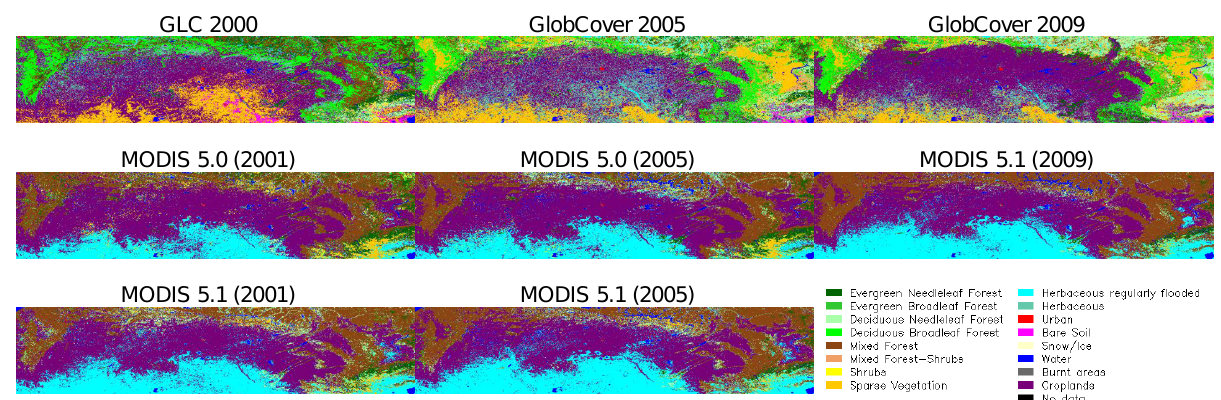
Figure 3. Comparison of five land cover products in southwest Siberia: GLC2000, GlobCover 2005 and 2009, MODIS 5.0 and 5.1 for 2001, 2005 and 2009, aggregated at 1km scale to a common legend.